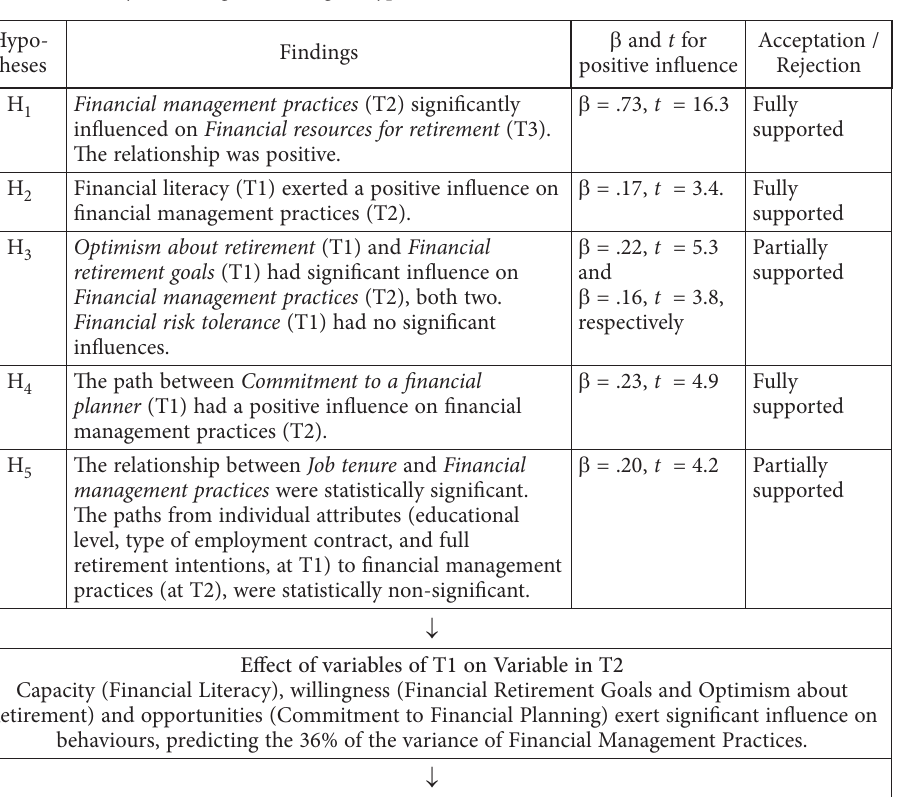
Table 5. Summary of findings according to hypotheses Hypo- Findings theses H 1 Financial management practices (T2) significantly influenced on Financial resources for retirement (T3). The relationship was positive.